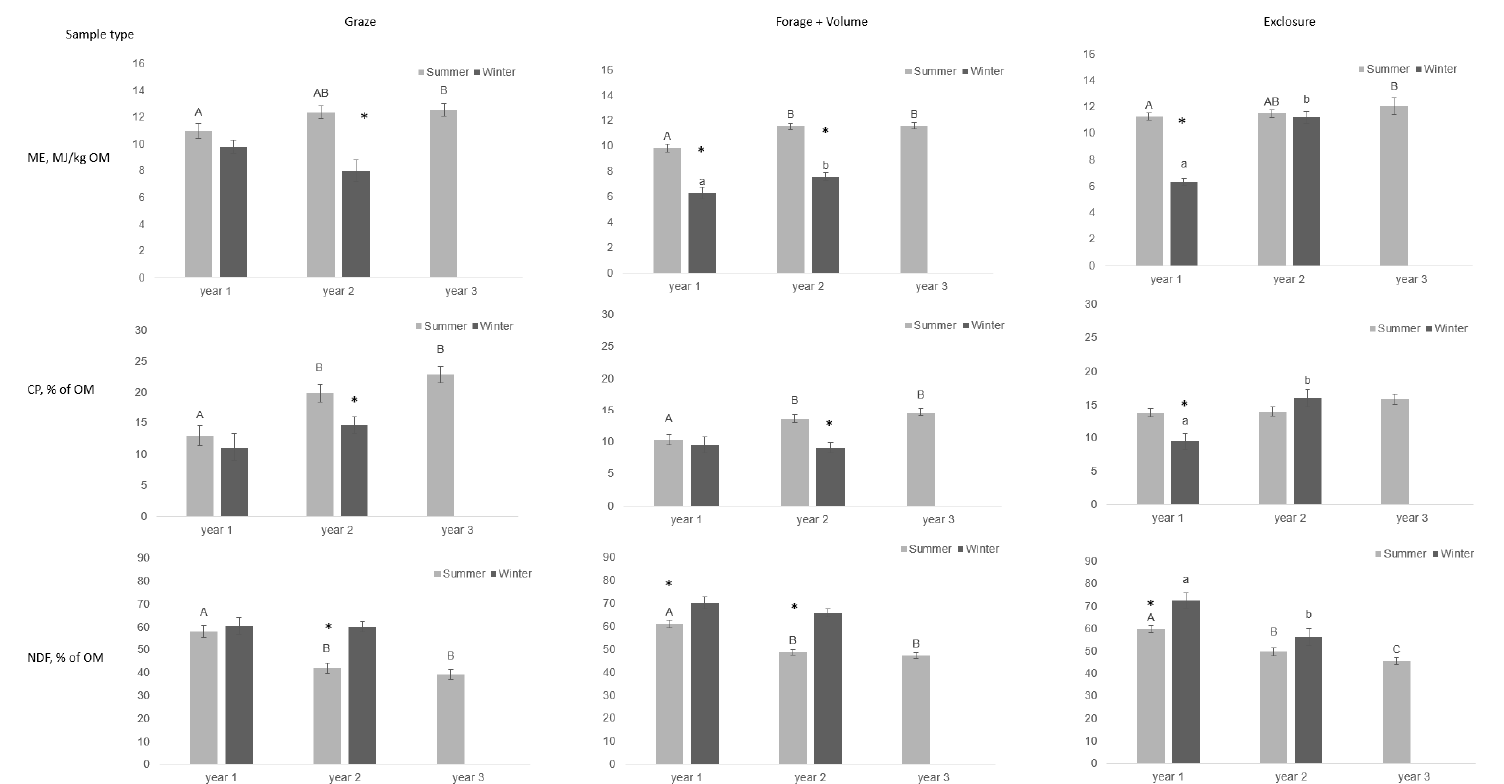
Figure 2. Content of metabolizable energy (ME) per kg organic matter (OM), crude protein (CP) as % of OM, and neutral detergent fiber (NDF) as % of OM in three types of pasture samples (graze, forage + volume, exclosure) collected monthly in three enclosures grazed by 12 Gotlandsruss between May 2014 and September 2016. One year is defined as start of summer season to end of winter season. Each enclosure contained three exclosures. An asterisk indicates significant difference between seasons within year ( p < 0.05). Different lowercase letters (a, b) indicate differences between years within winter season, while different uppercase letters (A, B) indicate differences between years within summer season ( p < 0.05).